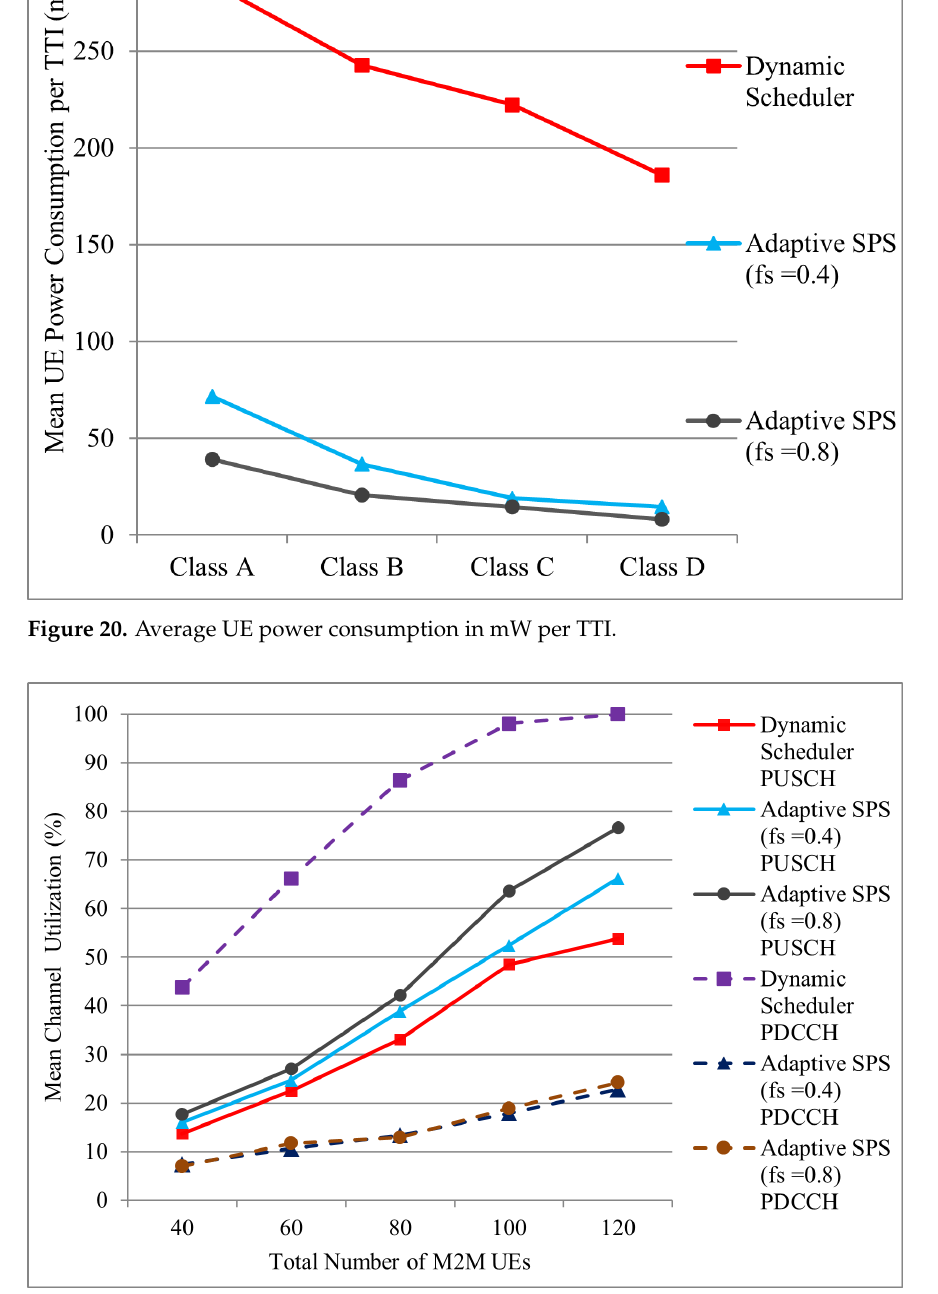
Figure 21. Comparison of channel utilizations with DRX power